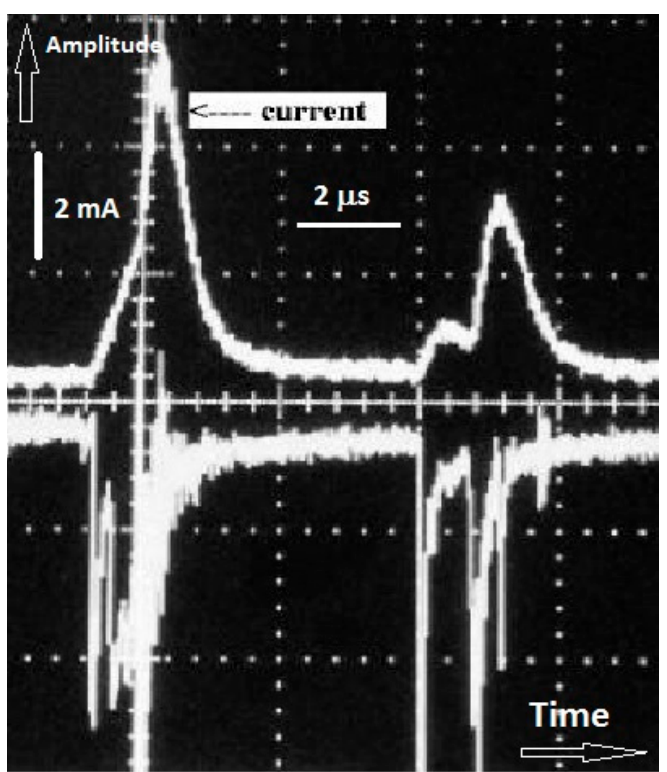
Figure 3. Current waveform (top curve) of a DC-powered (20 kV) RBD and discharge integrated light intensity detected by a photomultiplier tube (PMT) (curve is inverted to visually distinguish it from the current waveform). Note the correlation between the timing of the current and light pulses.